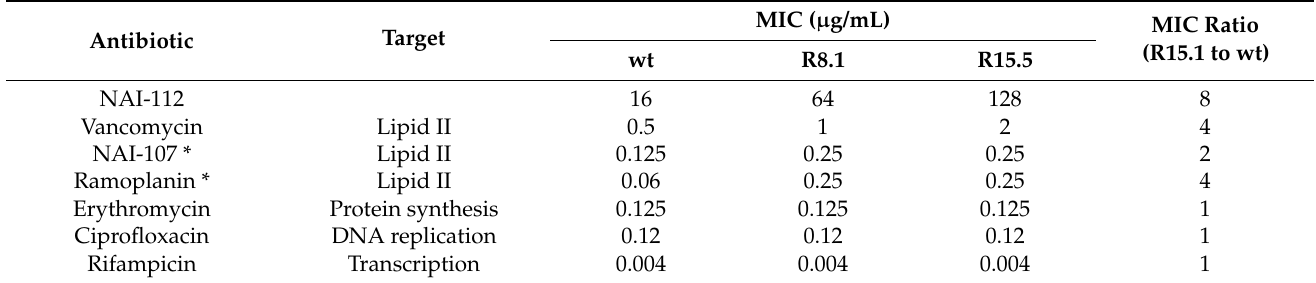
Table 1. MICs ( μ g/mL) of selected antibiotics against NAI ‐ 112 ‐ resistant strains. Table 1. MICs ( µ g/mL) of selected antibiotics against NAI-112-resistant strains.